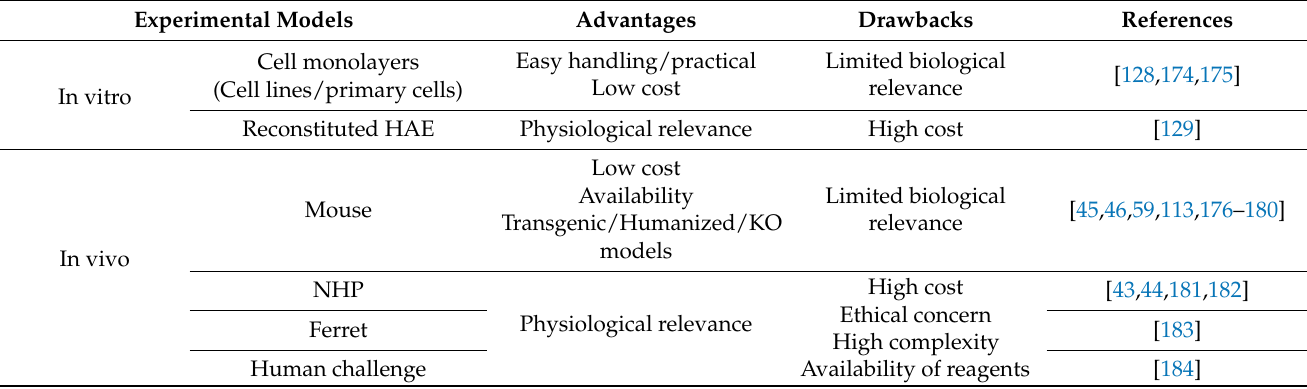
Table 1. Overview of the available experimental models for the study of viral/bacterial co-infections, with their respective advantages and drawbacks. Experimental Models Advantages